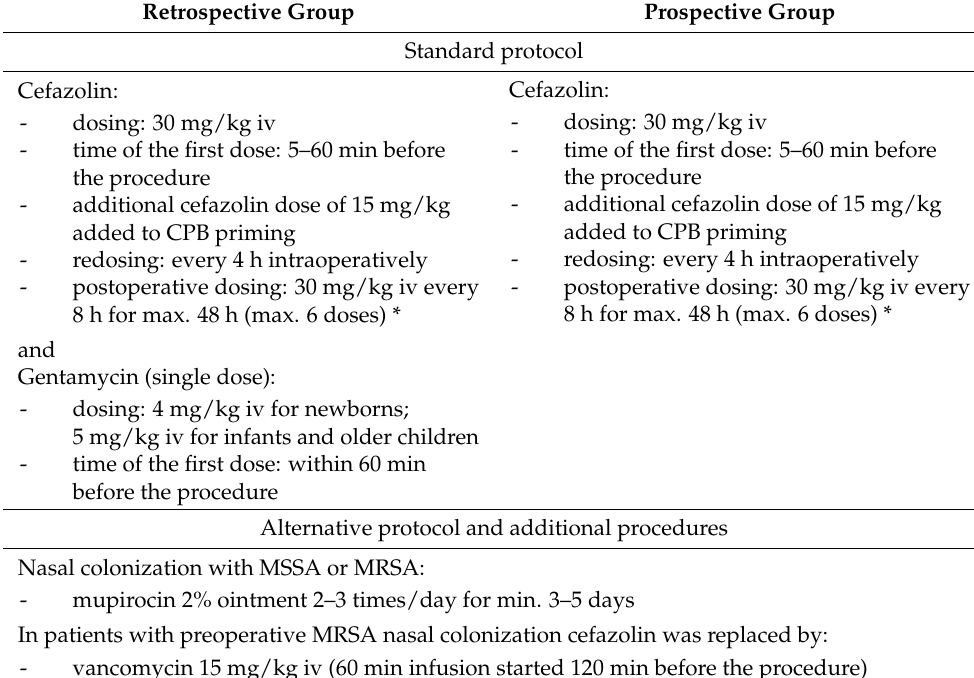
Table 4. Antibiotic prophylaxis schemes used in the